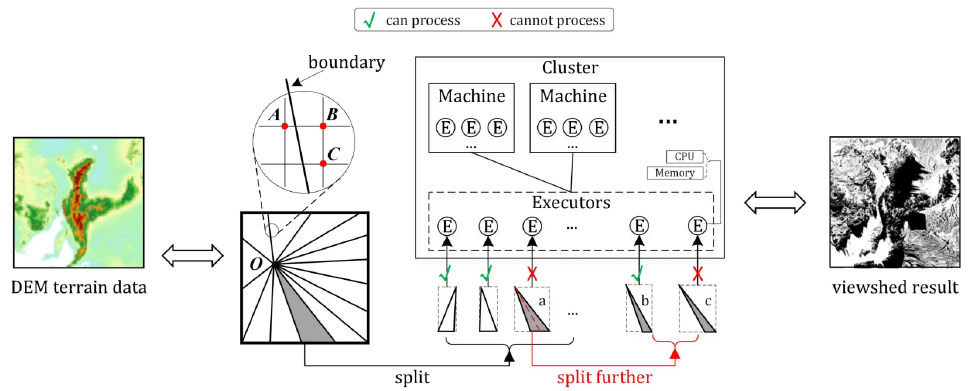
Figure 1. The distributed XDraw algorithm with equal area decomposition strategy based on Spark, O is the